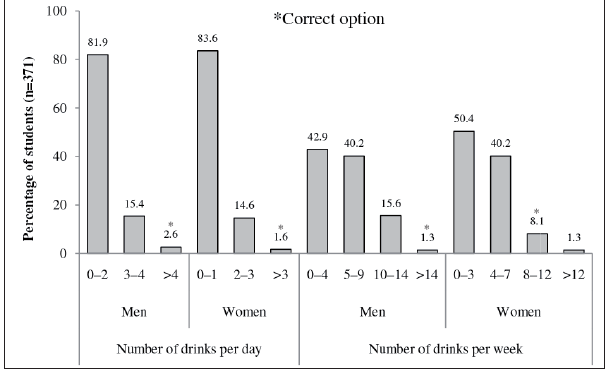
Fig. 1. Students’ views of what they regarded as the daily and weekly maximum limits for safe drinking for men and women.